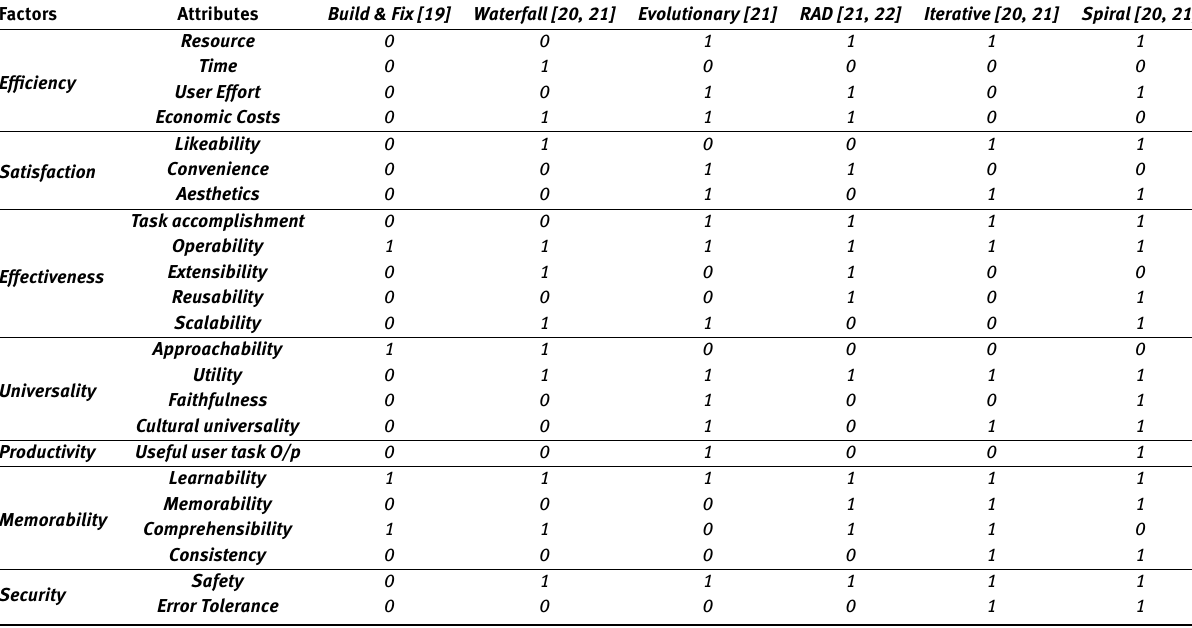
Table 2: Detailed analysis of SDLC models using seven factors and 23 attributes of the proposed model Factors